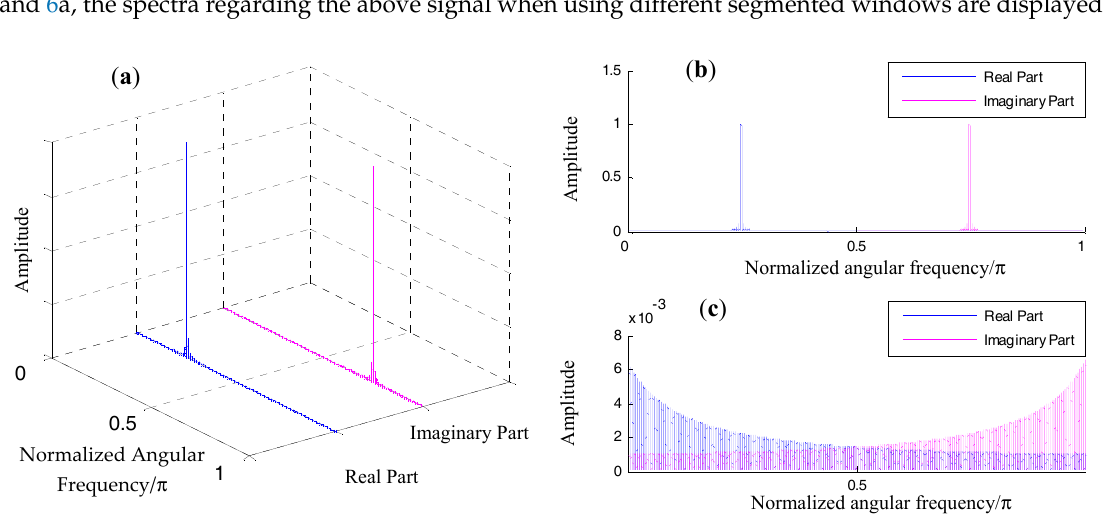
Figure 5. Demonstration of spectral aliasing of rectangular window: ( a ) magnitude response of the positive component and the negative component in a 3D coordinate; ( b ) magnitude response of the positive component and the negative component in a 2D coordinate; ( c ) zoomed-in plot of ( b ).